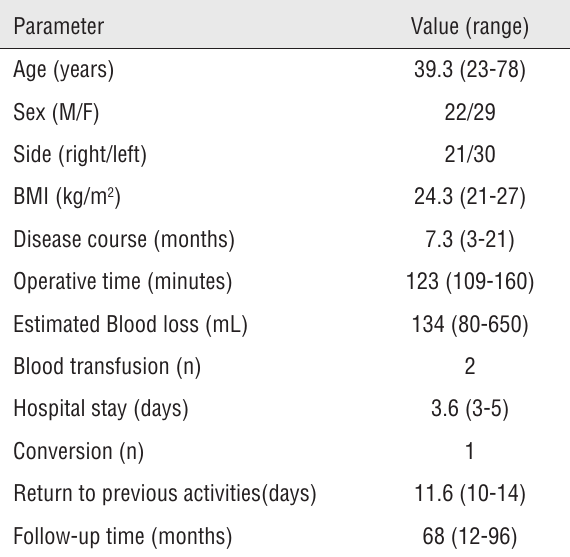
Table 3 - Postoperative complications stratified according to the modified Clavien classification. Clavien Grade n